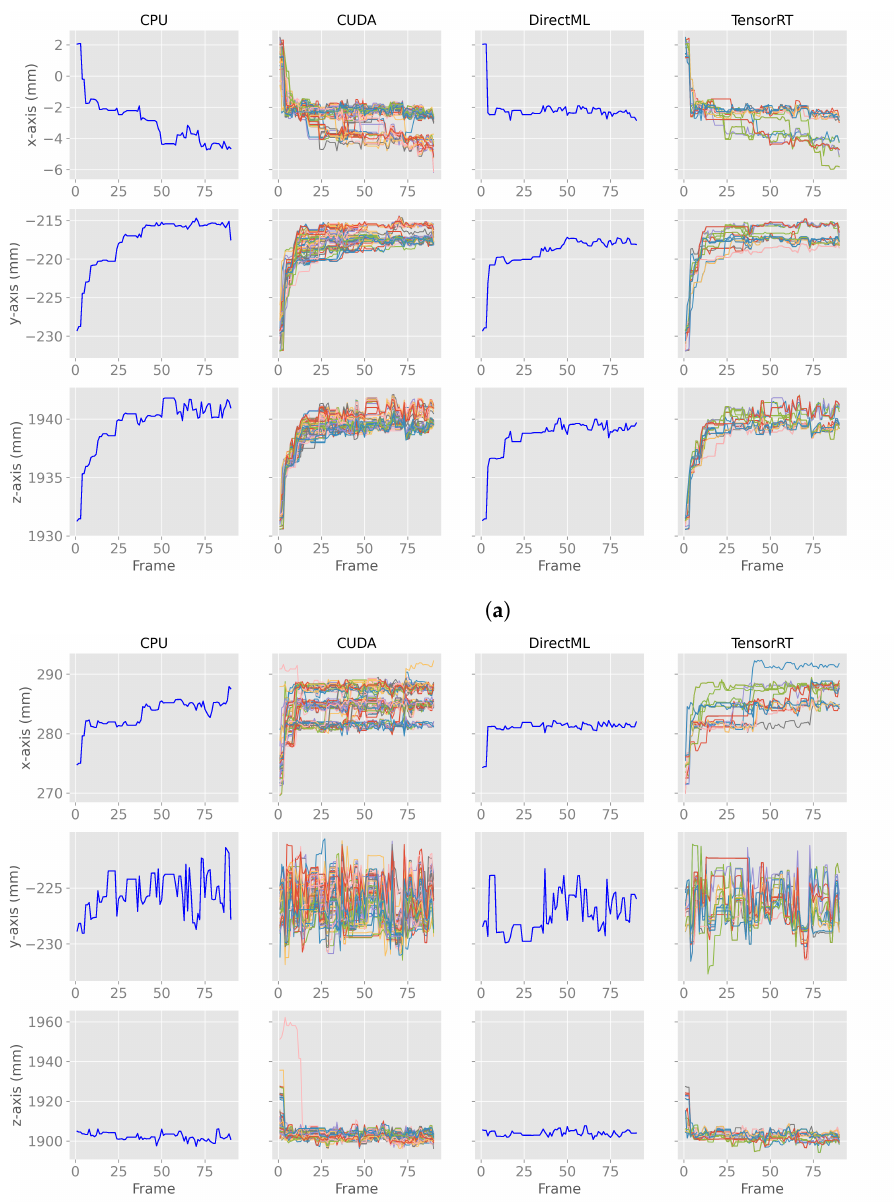
Figure 3. X -, y -, z -axes of the first 90 body tracking frames using 100 body tracking runs for all four processing modes for joint positions of PELVIS and WRIST_LEFT. Note: the runs for CPU and DirectML yielded the same results for each run and, therefore, appear as a single line. ( a ) X -, y -, z -axes of the first 90 body tracking frames for the joint position of PELVIS. ( b ) X -, y -, z -axes of the first 90 body tracking frames for the joint position of